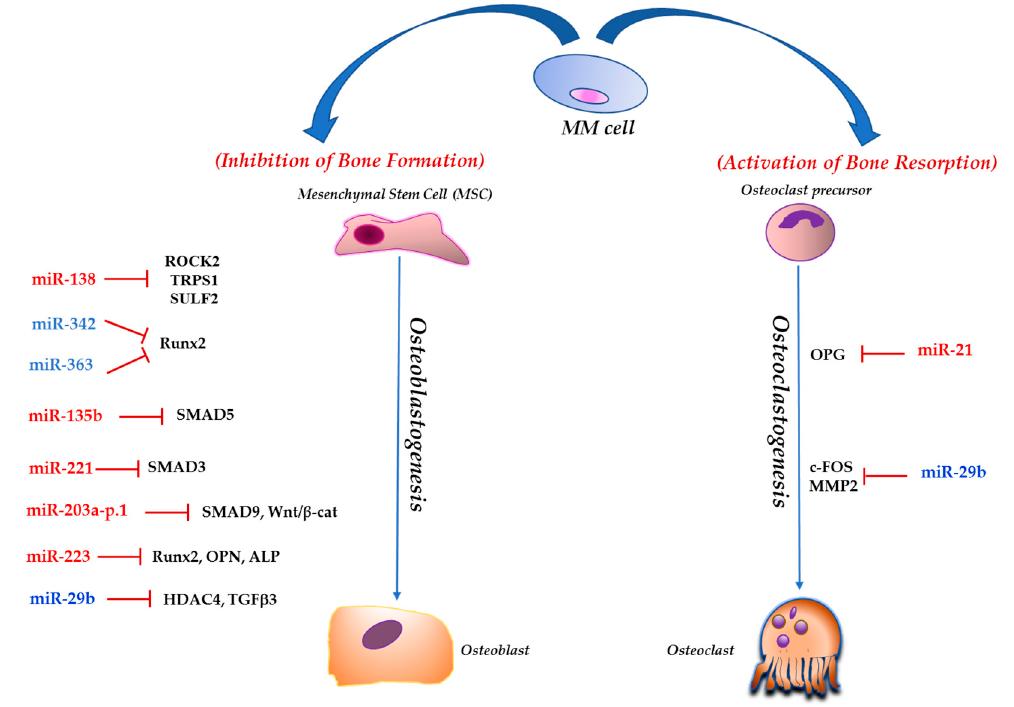
Figure 1. The picture reports microRNAs (miRNAs) and their corresponding mRNA targets involved in osteoblastogenesis and osteoclastogenesis processes in the multiple myeloma (MM) bone marrow microenvironment (BMM). miRNAs triggering bone resorption are reported in red; miRNAs triggering bone apposition are reported in